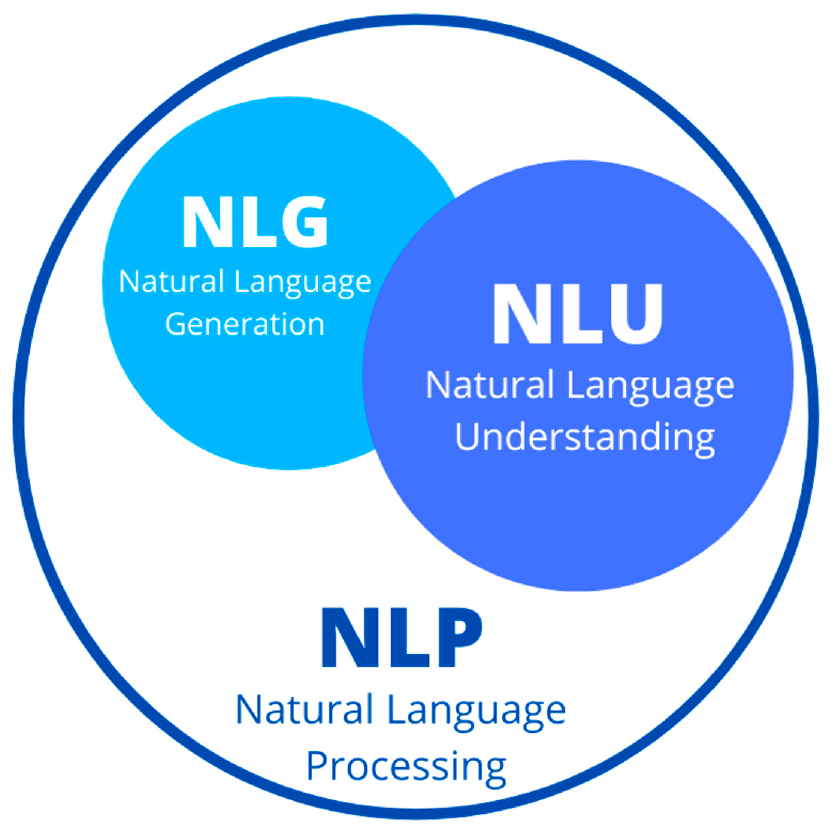
Figure 1. NLP models can be divided into two subsections: NLG and NLU (Source: Authors).